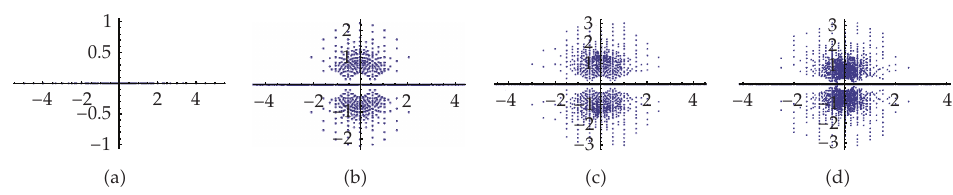
Figure 12: The roots of the Newton polynomials P (cid:5) z,w (cid:6) at z (cid:7) 1, for (cid:5) a (cid:6) the conifold, (cid:5) b (cid:6) F 0 , (cid:5) c (cid:6) dP 1 , and (cid:5) d (cid:6) dP 3 .